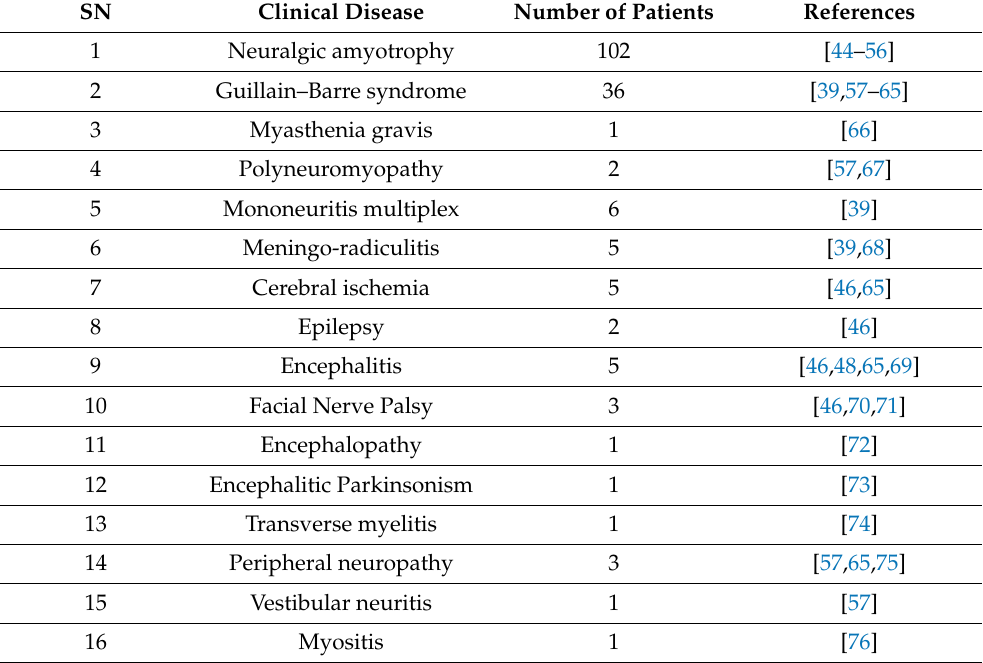
Table 1. Nervous and musculoskeletal system disorders related to HEV infection. SN Clinical Disease Number of